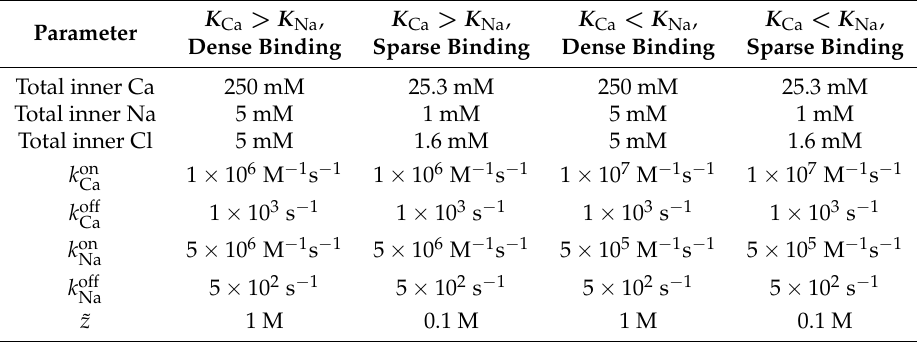
Table 2. Parameters that vary between